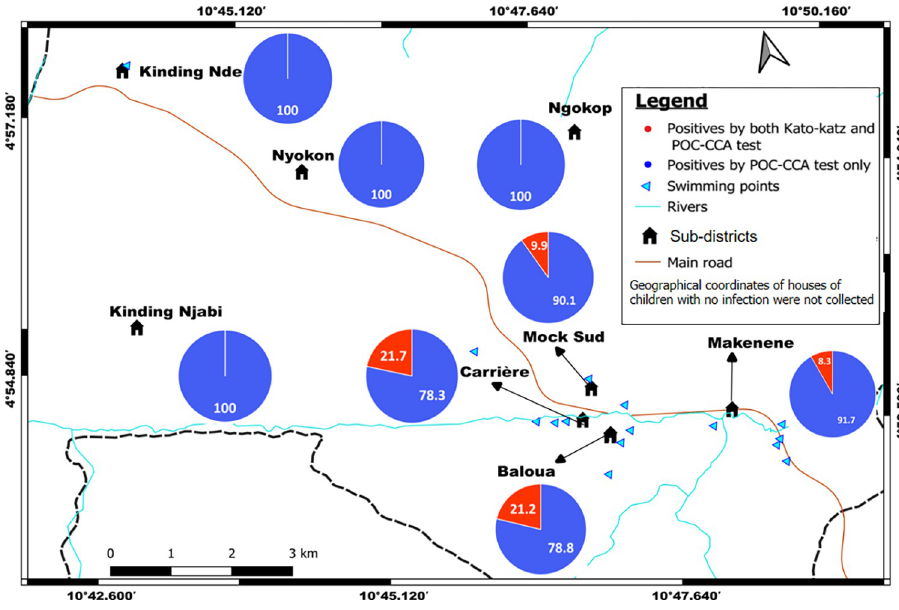
Fig 6. Sub-districts distribution of the percentage of children with S . mansoni infections based on POC-CCA and KK results (base layer of the maps were obtained using a free online spatial data software (https://www.diva-gis.org/gdata).